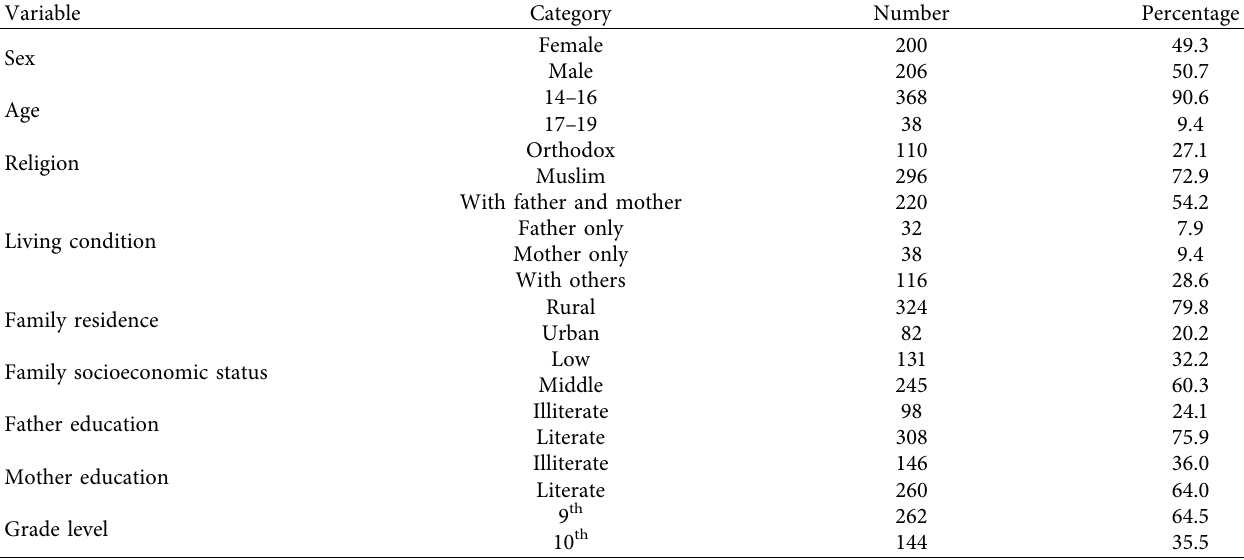
Table 1: Sociodemographic characteristics of adolescent students in Legehida district, Northeast Ethiopia, 2018.